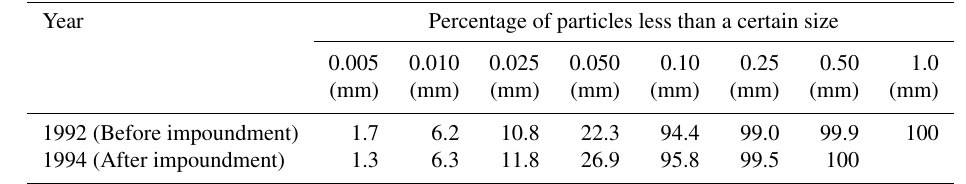
Table 2. Particle size composition of suspended sediment of Minjiang River at Zhuqi before and after Shuikou reservoir impoundment. Year